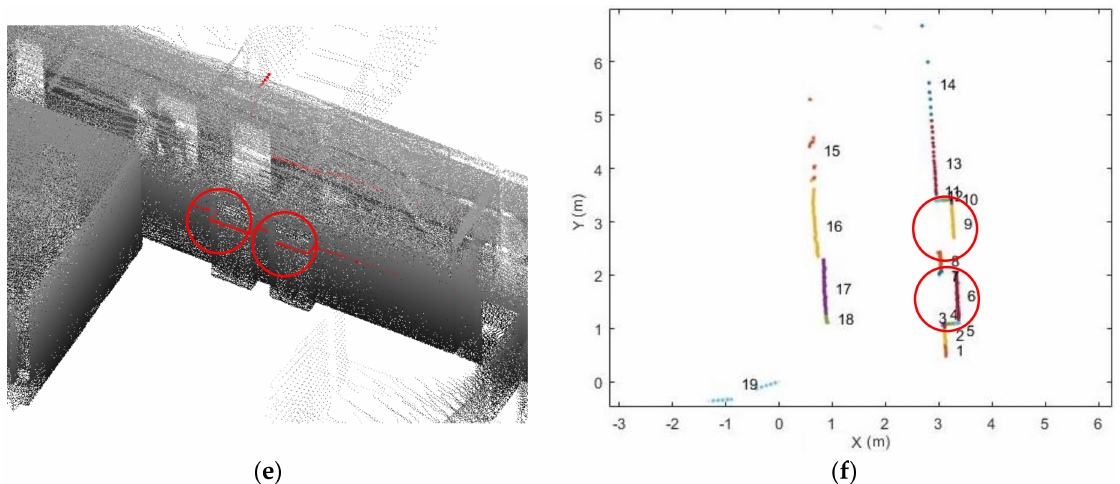
Figure 7. Comparison of the openings in 3D and 2D: ( a , b ) windows in the scanline; ( c , d ) open doors in the scanline; ( e , f ) closed doors in the scanline (red circle: opening, each segment is shown in a different